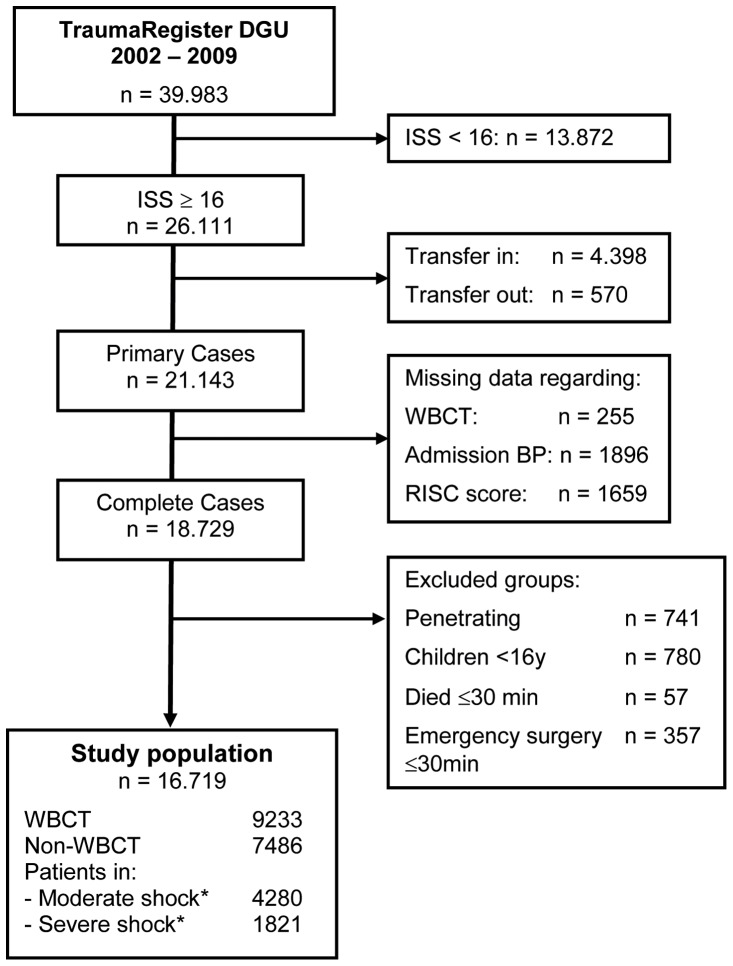
STROBE diagram of study population.ISS  =  Injury severity score, WBCT  =  whole-body CT, BP  =  blood pressure on hospital admission; RISC  =  revised injury severity classification score; transfer in patients: no data of resuscitation in primary hospital; transfer out patients (<48 h): no outcome data of final hospital; missing and excluded groups: overlapping numbers possible; * moderate shock on hospital admission: BP  = 90–110 mmHg; * severe shock on hospital admission: BP <90 mmHg.